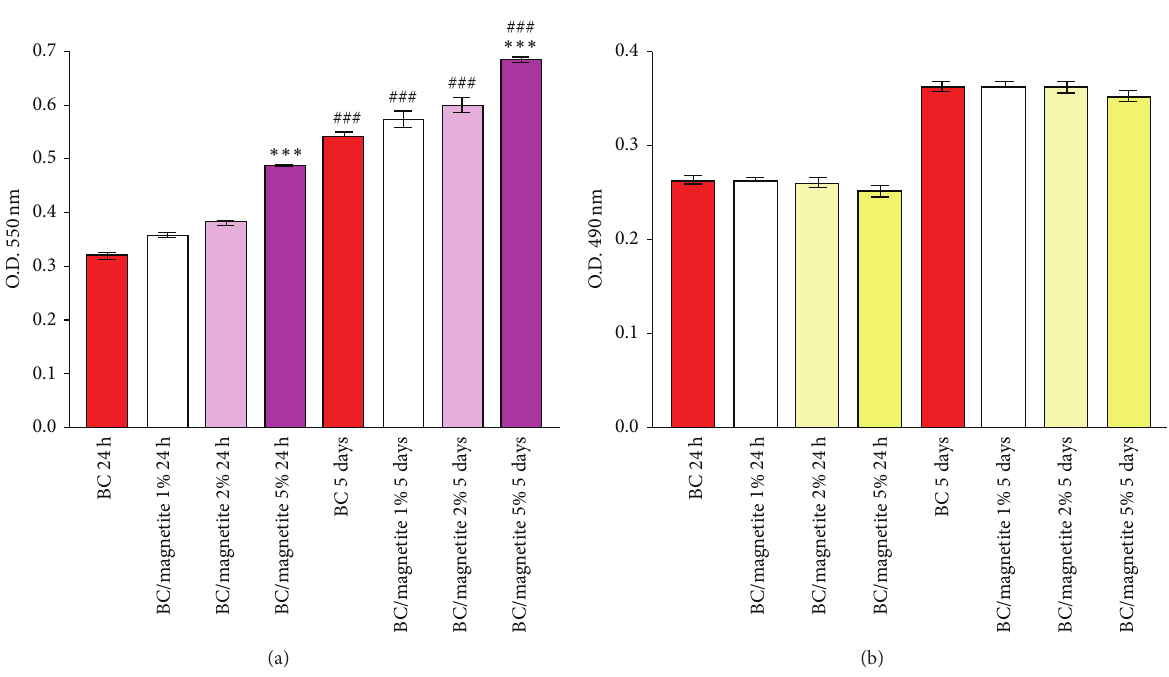
Figure 9: Quantification of (a) hASCs viability on pure BC, BC/magnetite 1%, BC/magnetite 2%, and BC/magnetite 5% nanocomposites, as revealed by MTT test at 24 h and 5 days postseeding. [ ∗∗∗ 𝑝 < 0.001 (hASCs/BC versus hASCs/BC/magnetite 5% nanocomposites) and ### 𝑝 < 0.001 (hASCs/BC 24 h versus hASCs/BC 5 days; hASCs/BC/magnetite 1% 24 h versus hASCs/BC/magnetite 1% 5 days; hASCs/BC/magnetite 2% 24 h versus hASCs/BC/magnetite 2% 5 days; hASCs/BC/magnetite 5% 24h versus hASCs/BC/magnetite 5% 5 days)] and (b) pure BC, BC/magnetite 1%, BC/magnetite 2%, and BC/magnetite 5% nanocomposites’ cytotoxic potential effect on hASCs after 24 h and 5 days of culture as revealed by LDH